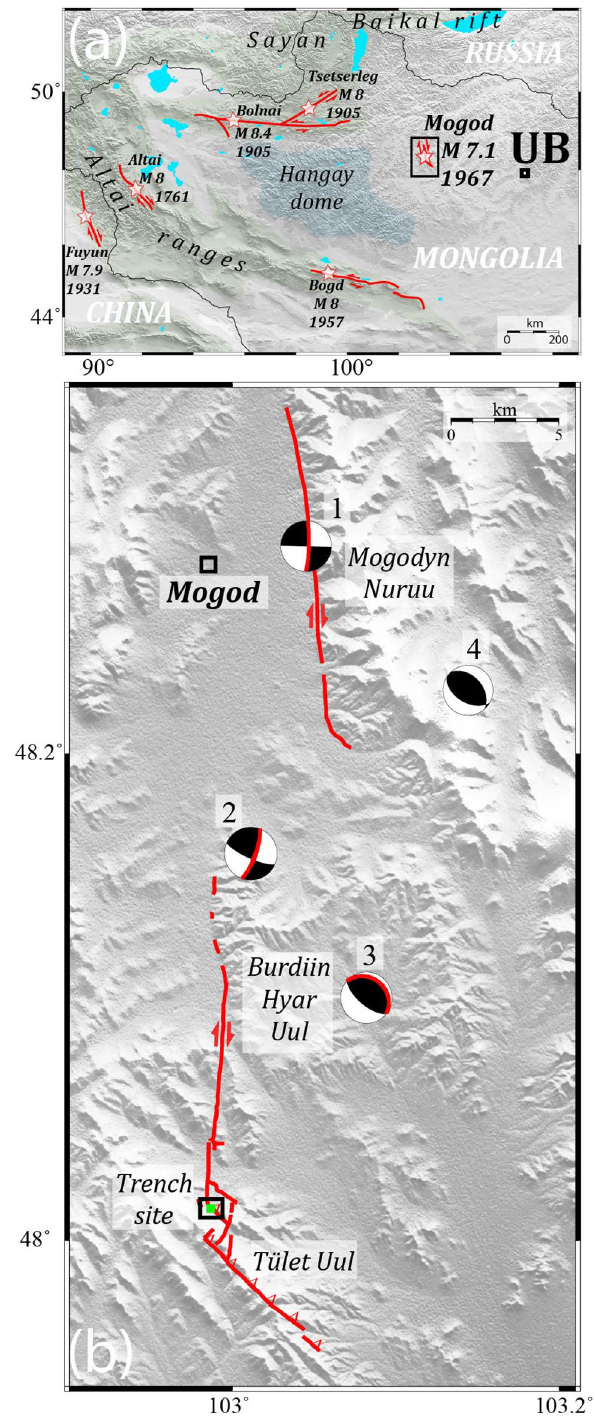
Figure 1. ( a ) Map of the large surface rupturing earthquakes of the last 300 years in Mongolia and vicinity. ( b ) Surface trace of the 1967CE rupture surveyed from high resolution images. Centroid Moment Tensors from Bayasgalan and Jackson, 1999. (1–2–3) label the 3 subsources of the Main shock in temporal order. (4) Is the largest aftershock that occurred on January the 20th